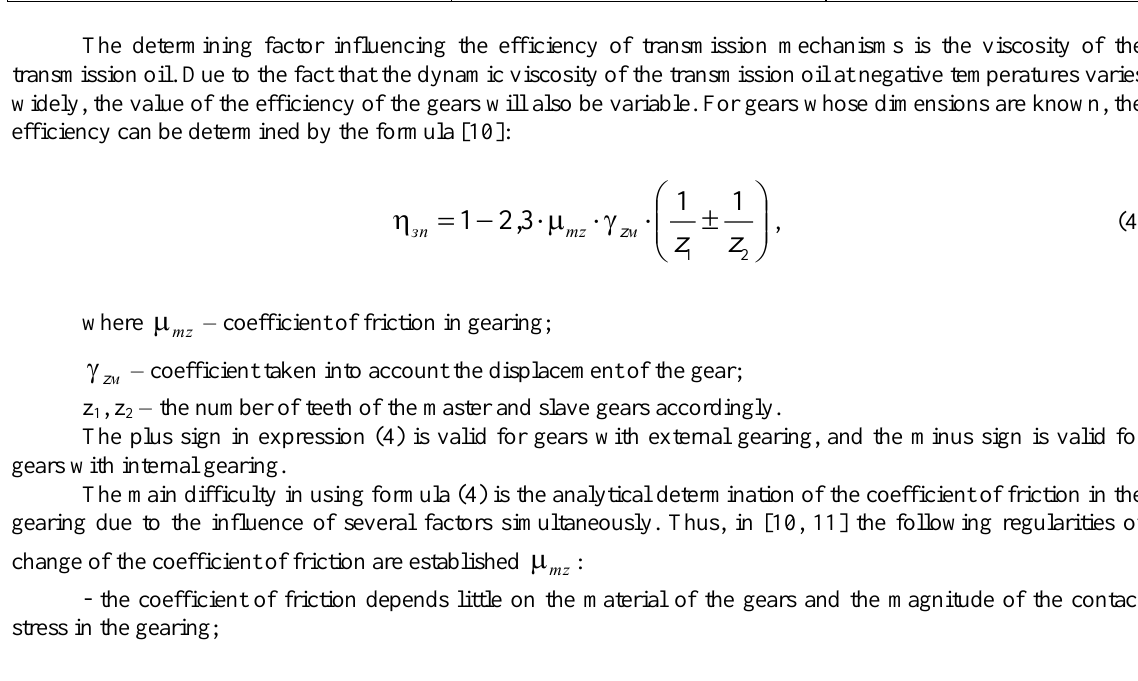
Typical values of efficiency of gears at the optimum temperature Average efficiency depending on the type of transmission Transmission status  conical, cylindrical, z п